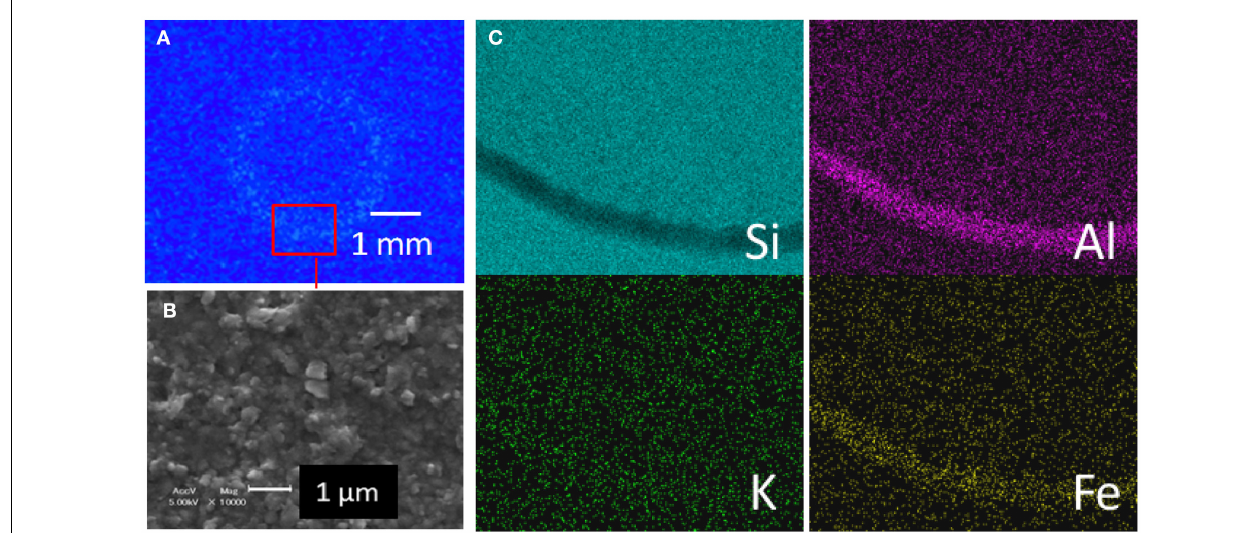
FIGURE 6 | (A) Autoradiography of a droplet of the suspended submicron-sized particles elutriated from OTO-W sample, which was dried on a smooth Si-metal plate. (B) A secondary electron image of a part of the area indicated by the red square in (A) . (C) A SEM–EDX elemental map obtained from the area indicated by the red square in (A)